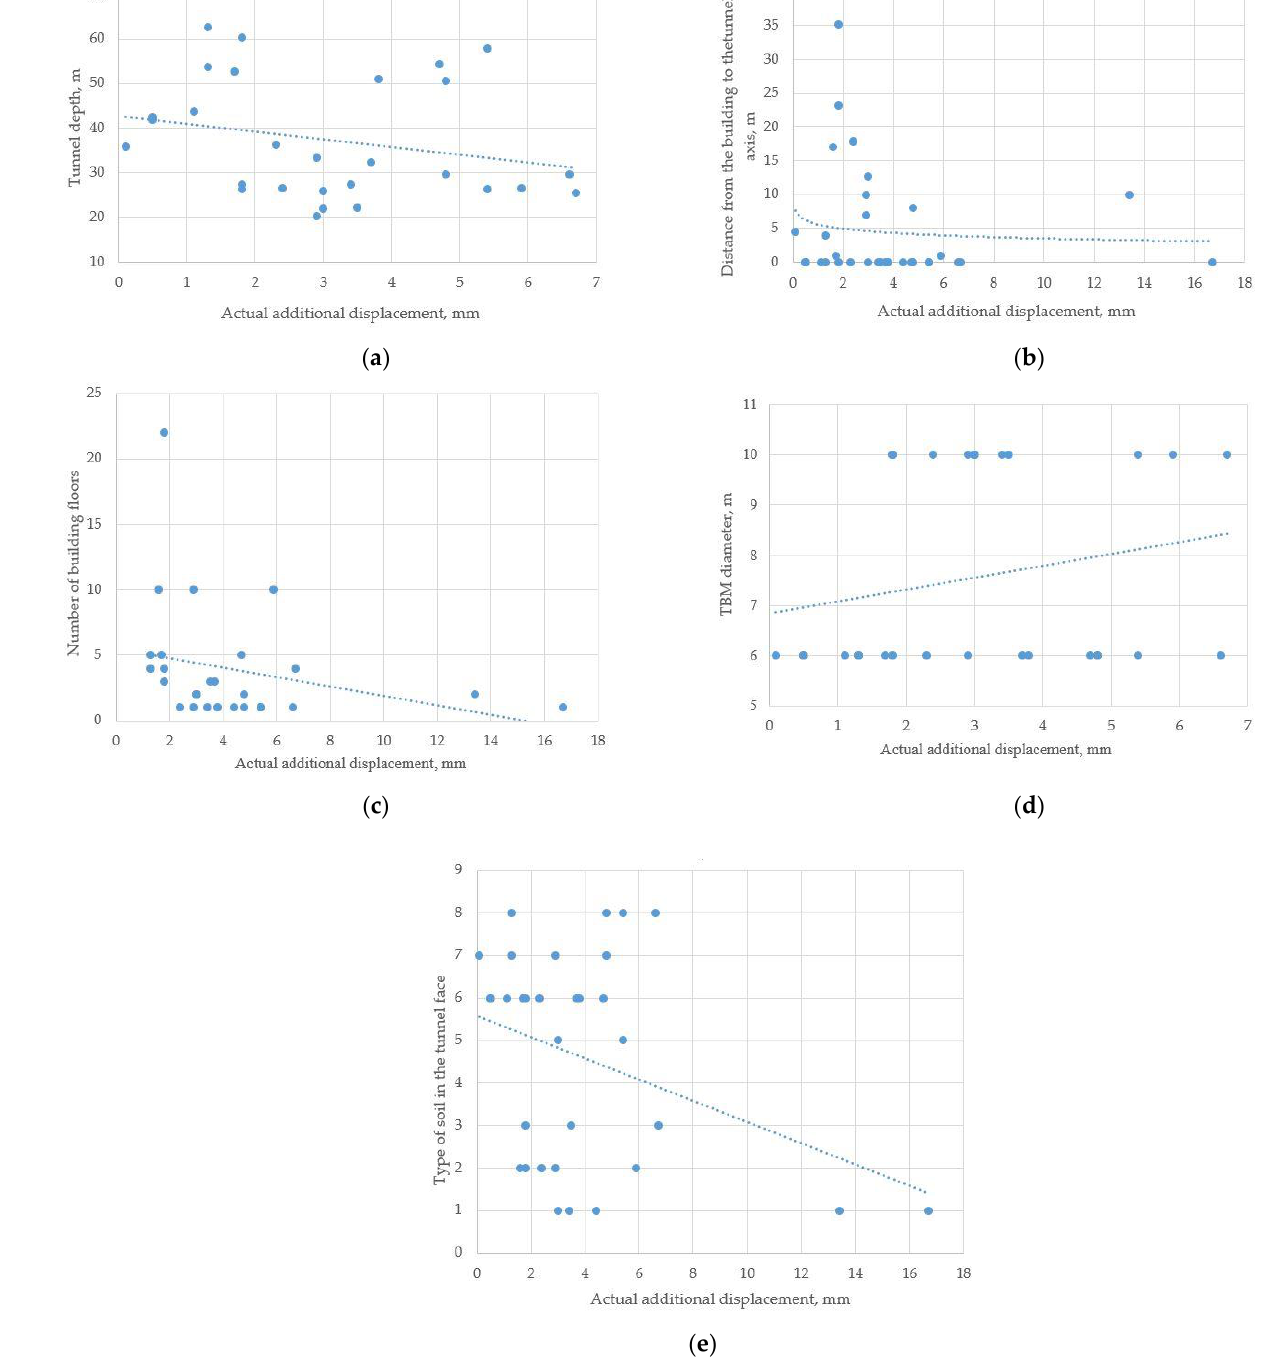
Figure 4. The dependence between the building settlement and various factors. ( a ) The dependence between the maximum building settlement and the tunnel depth; ( b ) the dependence between the maximum building settlement and the distance of the building from the tunnel axis in the plan; ( c ) the dependence between the maximum building settlement and the building height; ( d ) the dependence between the maximum building settlement and the TBM diameter; ( e ) the dependence between the maximum building settlement and the soil type in the tunnel face, where 1 is sand, 2 is loam with some sand, 3 is loam, 4 is clay with some loam, 5 is clay, 6 is marlstone, 7 is limestone with clay interlayers, and 8 is limestone.